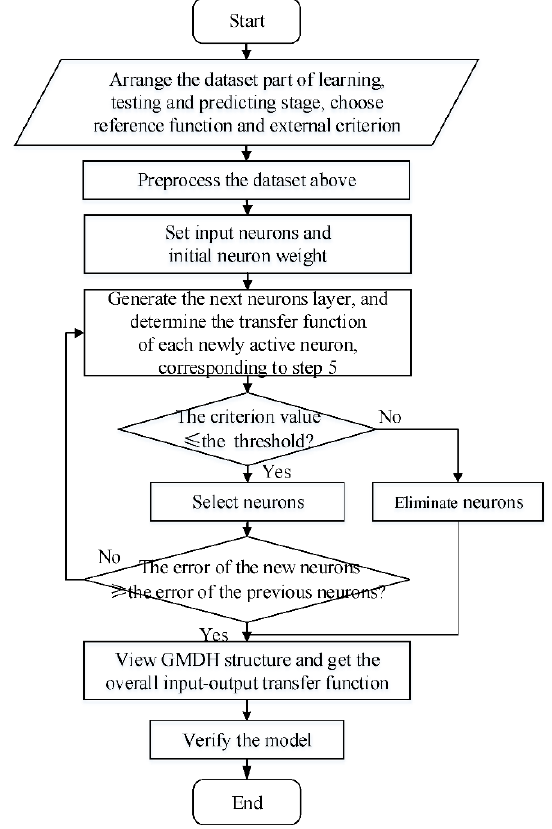
Figure 5. Flow chart for prediction of surface roughness by GMDH.